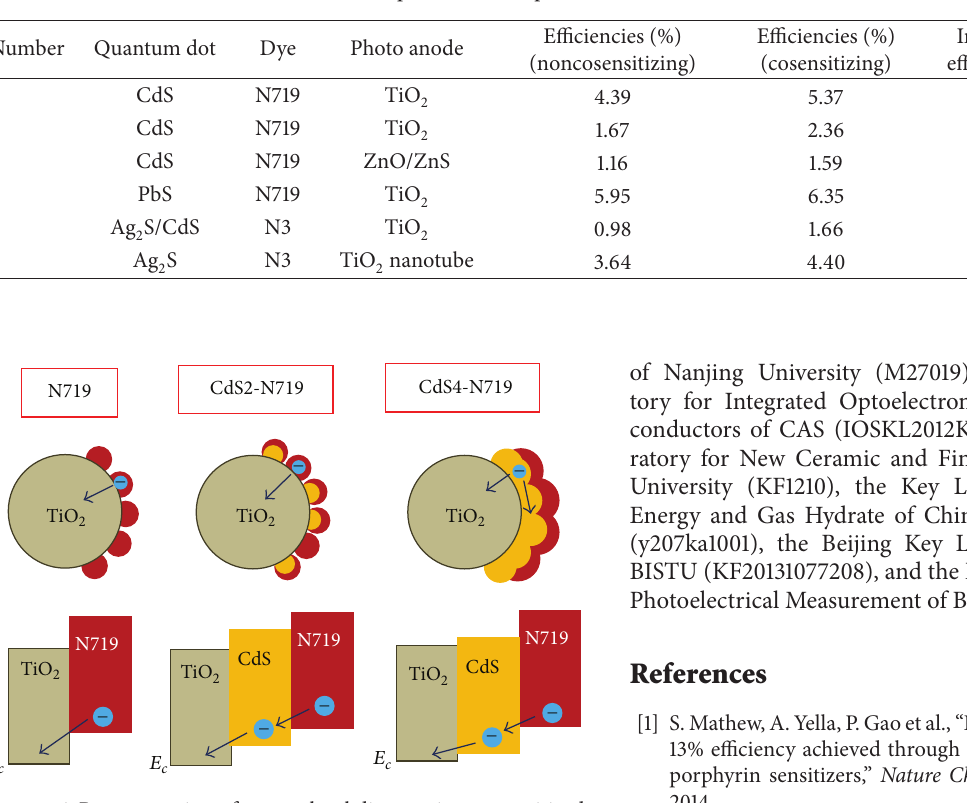
Table 3: The comparisons of the performance to other related cosensitized DSSCs.